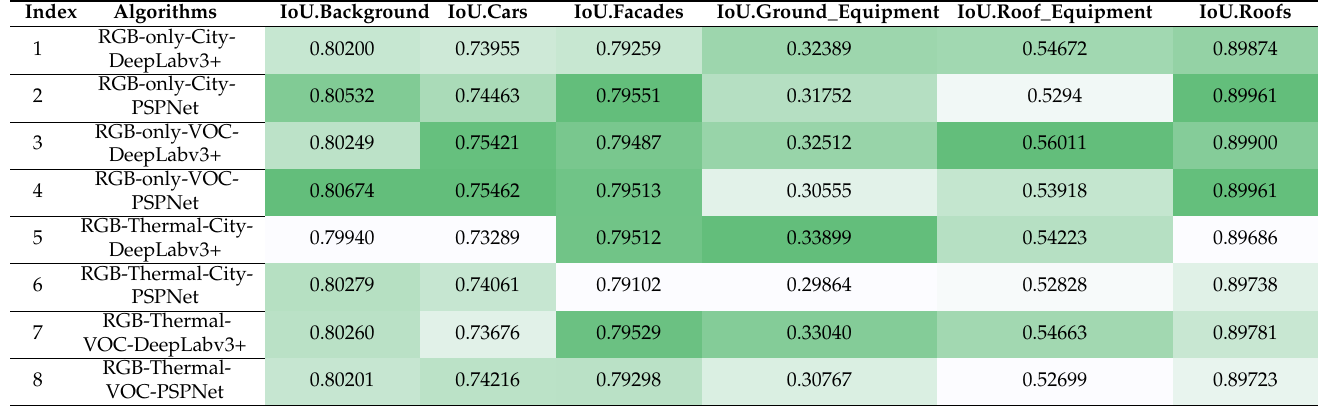
Table 4. Performance evaluation of PSPNet and DeepLab v3+ in terms of